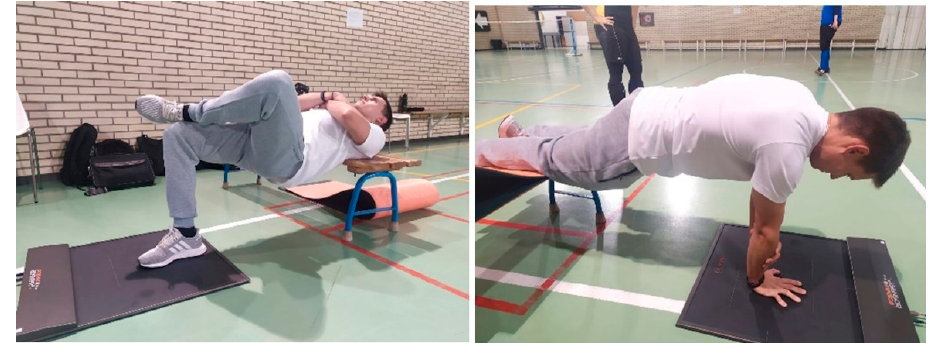
Figure 2. Core stability test positions: single leg hip thrust (left) and single arm plank (right).